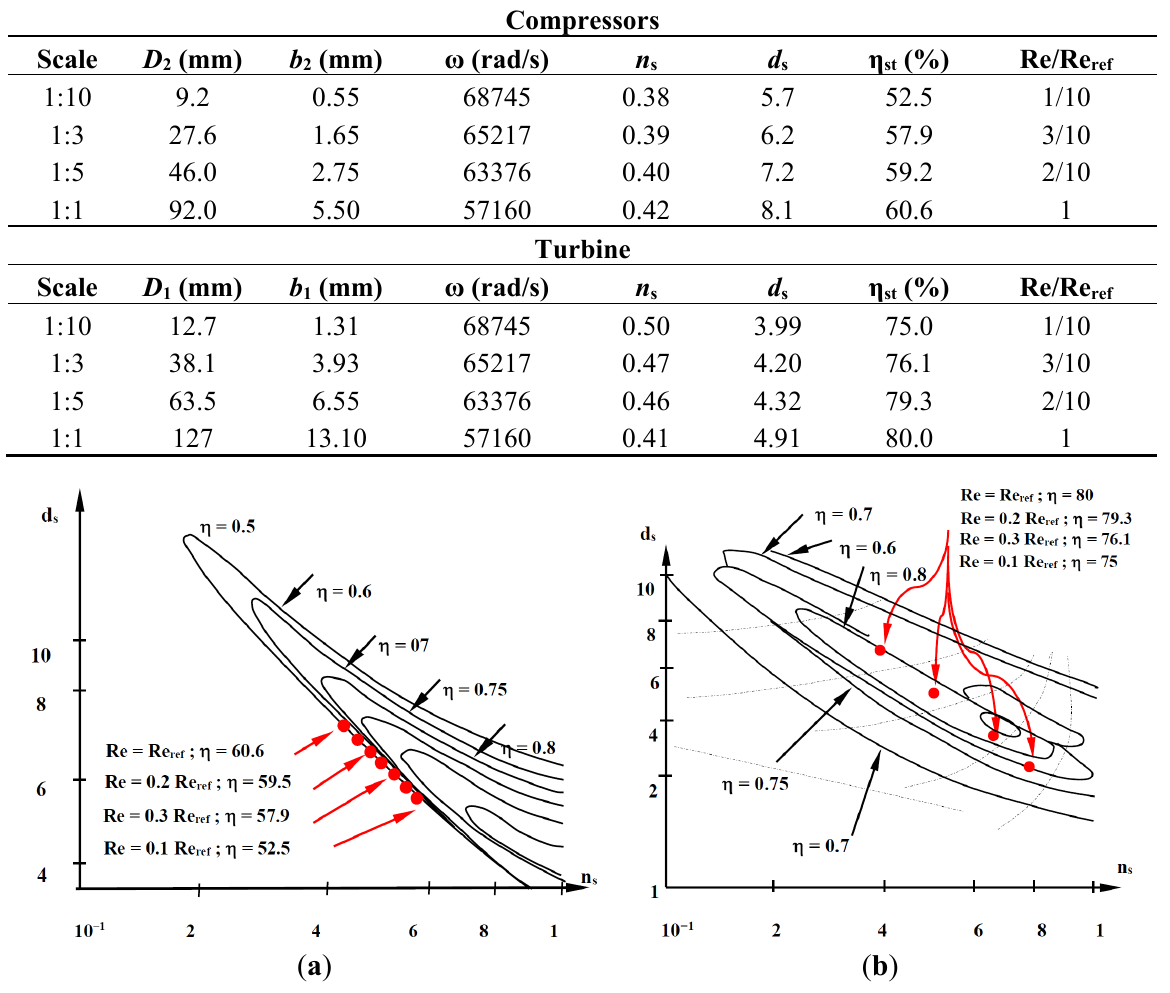
Figure 2. Computed efficiencies n s for ( a ) turbine and ( b ) compressor . Re ref = 10 6